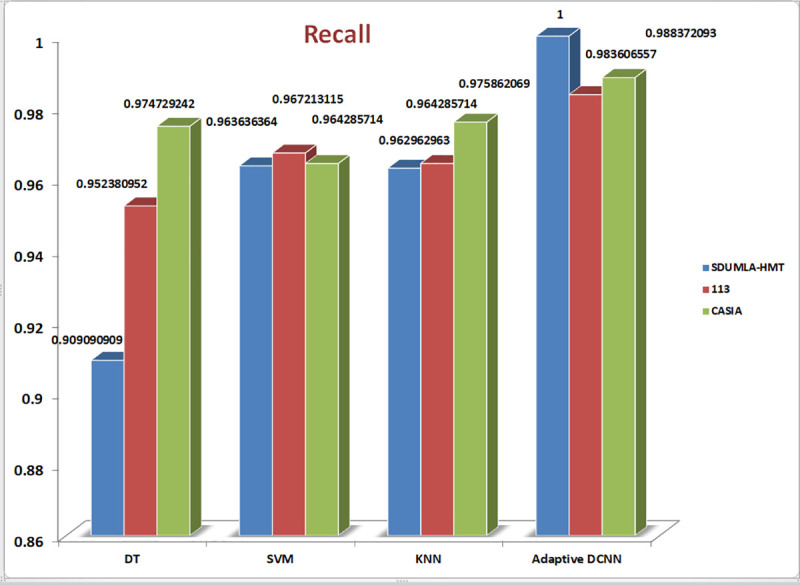
Recall of the proposed system and the three comparison systems.